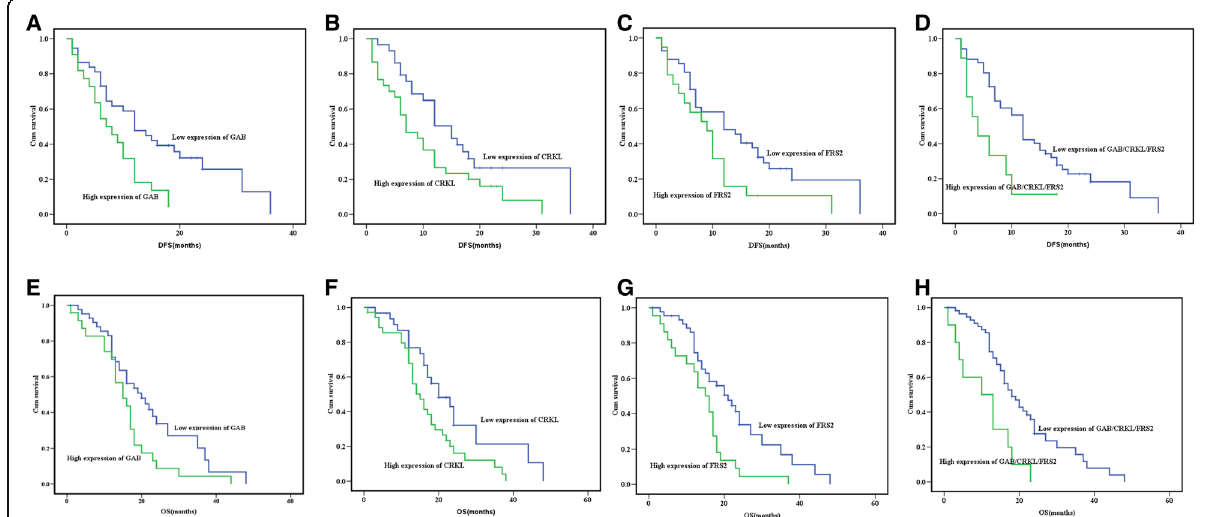
Fig. 4 Kaplan-Meier curves of DFS and OS with different expression patterns of GAB2, CRKL, and FRS2. DFS according to GAB2 expression pattern ( P =0.005) ( a ) CRKL expression pattern ( P =0.036) ( b ) FRS2 expression pattern ( P =0.037) ( c ) and GAB2/CRKL/FRS2 co-expression pattern ( P =0.015) ( d ). OS according to GAB2 expression pattern ( P =0.031) ( e ) CRKL expression pattern ( P =0.020) ( f ), FRS2 expression pattern ( P =0.003) ( g ) and GAB2/CRKL/ FRS2 co-expression pattern ( P =0.001) ( h )